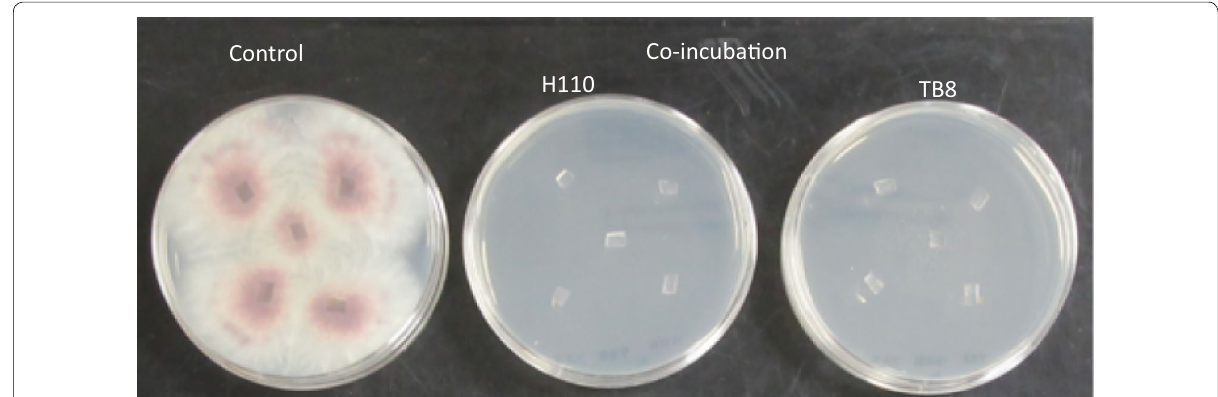
Fig. 5 Growth of mycelium of Fusarium oxysporum f. sp. spinaciae strain M2-1 from agar sections incubated alone without anaerobic bacterial strains (control) or co-incubated with strains H110 or TB8 for 7 days at 30 °C in the PY broth containing wheat bran (1%, w/v) as a substrate. The